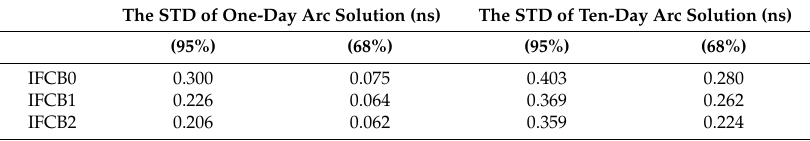
Table 6. The uncertainty (STD) of the GLONASS PPP solutions with fixed coordinates (ns). The STD of One-Day Arc Solution (ns)